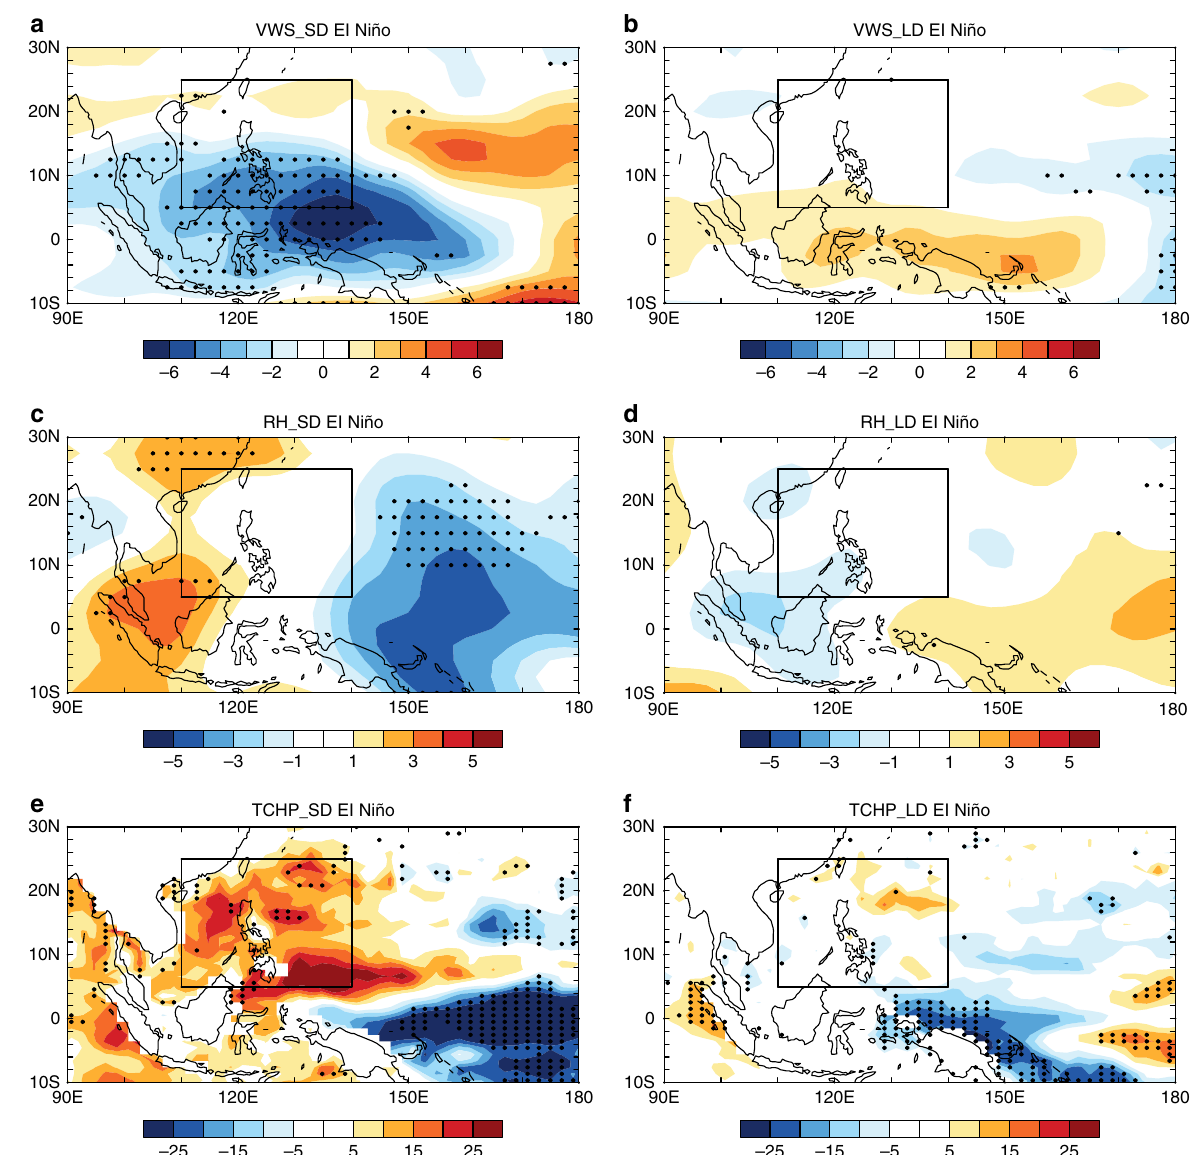
Fig. 2 Large-scale climate factors associated with the short duration and long duration El Niño events. Composite anomalies of a vertical wind shear (units: m s – 1 ), c relative humidity (units: %), and e tropical cyclone heat potential (units: 10 7 J m – 2 ) in July – November for the short duration El Niño events, b , d , and f as in a , c , and e , but for long duration El Niño events. Black boxes indicate the South China Sea and the Western Philippine Sea region. The vertical wind shear and relative humidity were from the NCEP-NCAR reanalysis dataset and the tropical cyclone heat potential was derived from the SODA reanalysis dataset. The stippled areas indicate the values are statistically signi fi cant at the 95% con fi dence